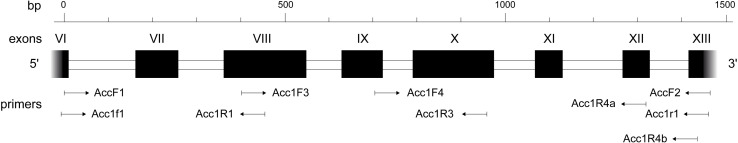
Schematic of the acetyl-CoA carboxylase gene (Acc1) modified from Huang et al. (2002) with designations, locations, and directions of the primers used.